Question: Does the plotted quantity increase or decrease?
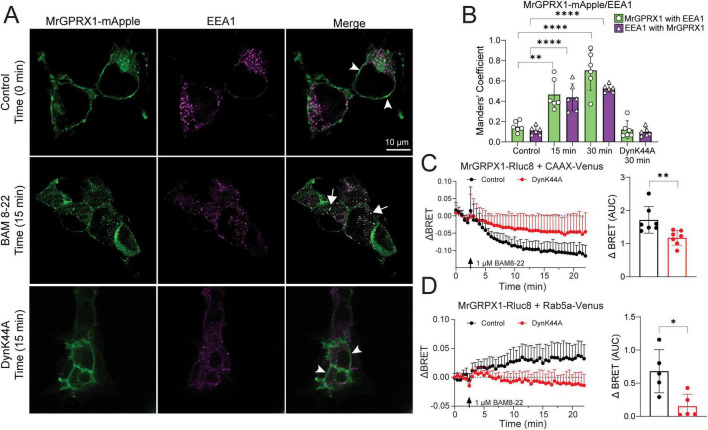
Answer: increasing